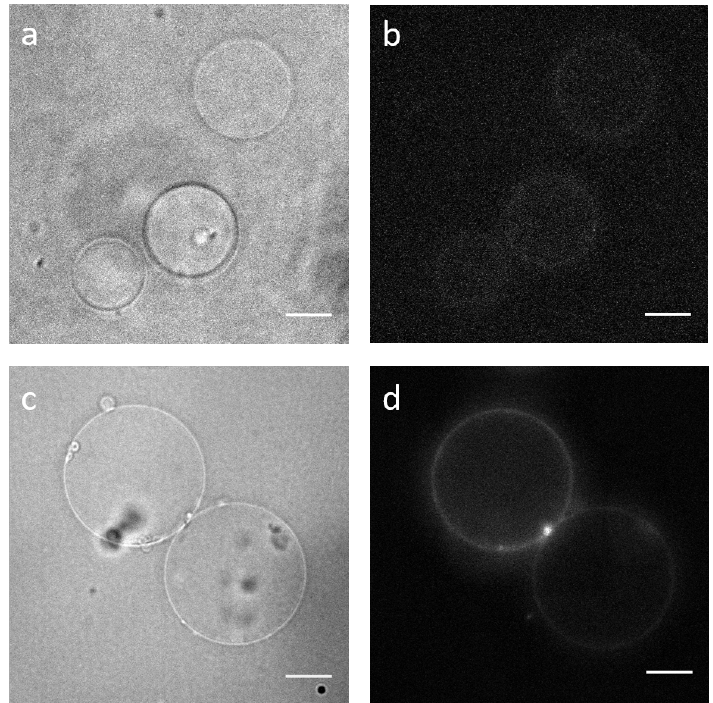
Figure 5. Comparison of pGUVs prepared using electro-swelling ( a , b ) and PVA-assisted swelling ( c,d ). Bright-field images of pGUVs ( a , c ) and epifluorescence images of incorporated integrins ( b , d ). Note that the diameter values reported in the text are population averages, and individual GUVs shown in the figure may be smaller or larger. Scale bars: 10 µ m.